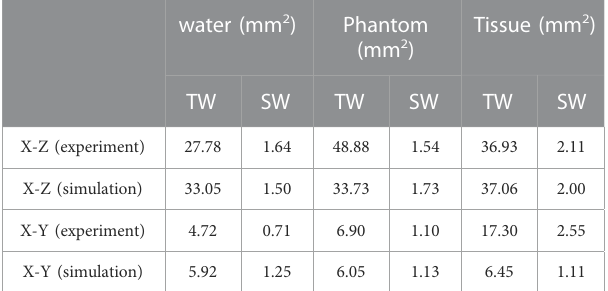
TABLE3Comparisonofthe − 6 dBfocalareaoftheTWandSWacoustic fi eldsin the experiment and